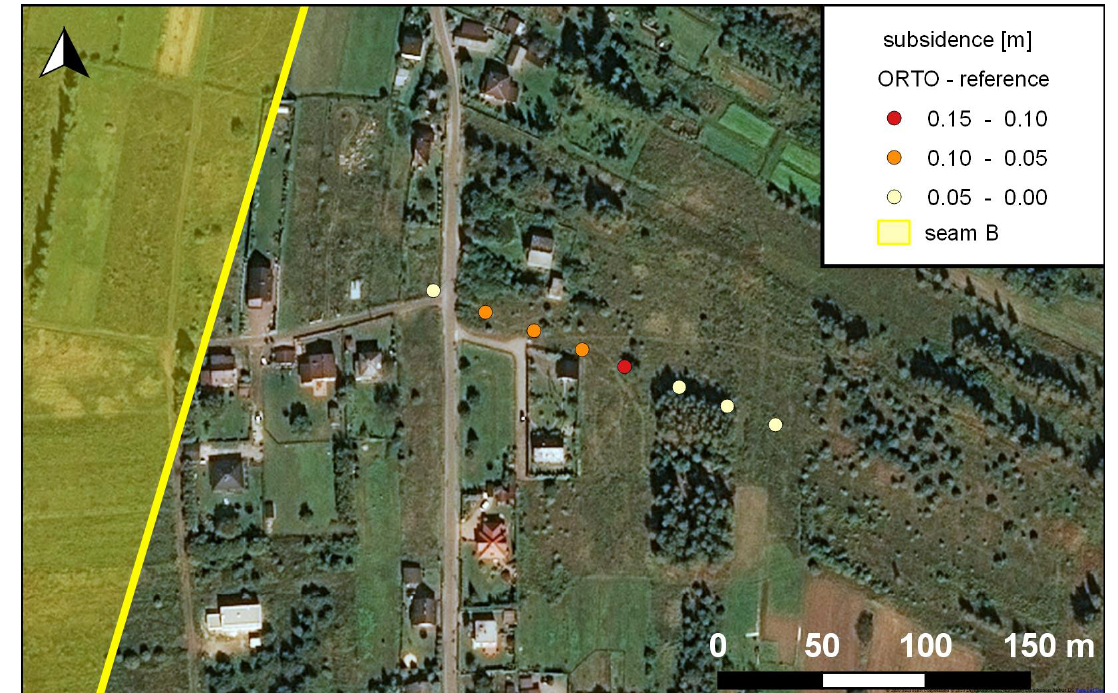
Figure A3. Horizontal displacements determined via the UAV photogrammetric method (ORTO method) and reference measurements at the Jaworzno site.